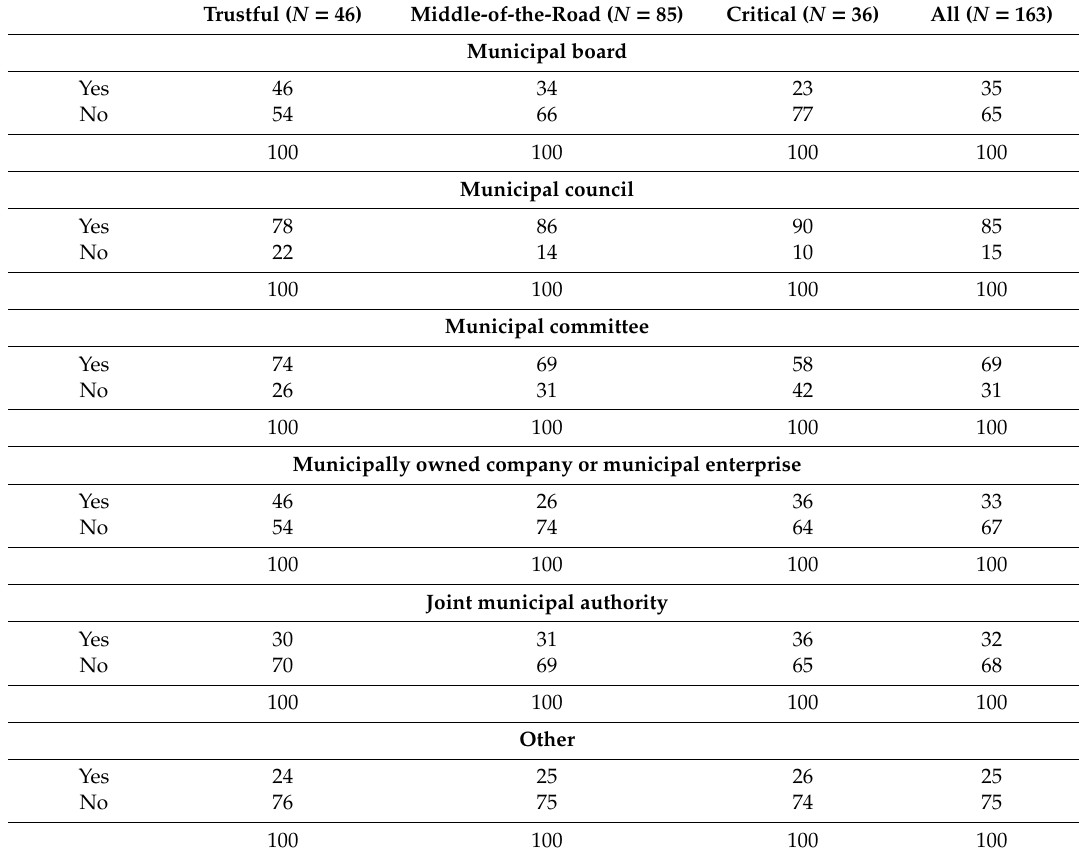
Table 2. Membership (%) of political organs at the time of data collection (member, chair or another person with the right to be